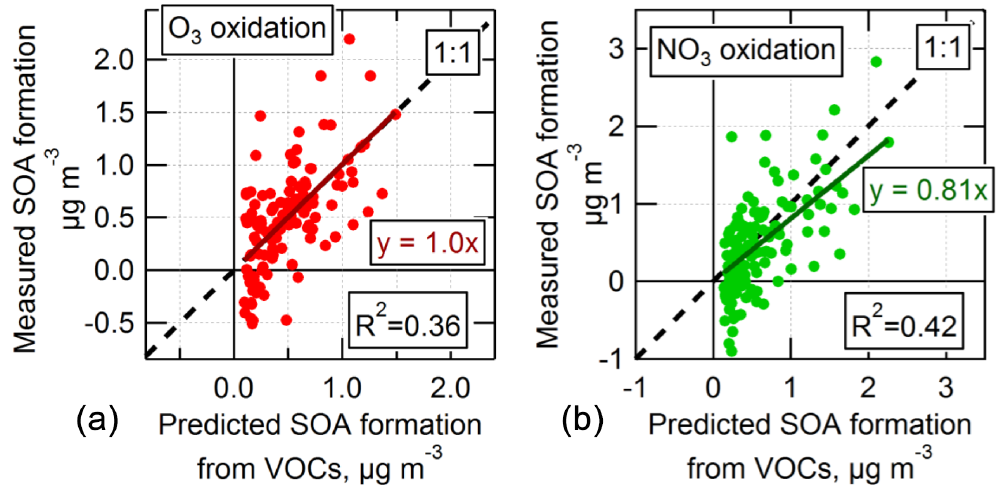
Figure 7. Measured vs. predicted SOA formation for O 3 and NO 3 oxidation in an OFR. The measured SOA formation includes the LVOC fate correction and includes all ages greater than 0.7 eq. d for O 3 -PAM and greater than 0.3 eq. d for NO 3 -PAM. Predicted SOA formation was estimated by applying published chamber SOA yields to the mass of VOCs predicted by the model to be oxidized in the OFR (see Sect. 2.3 for